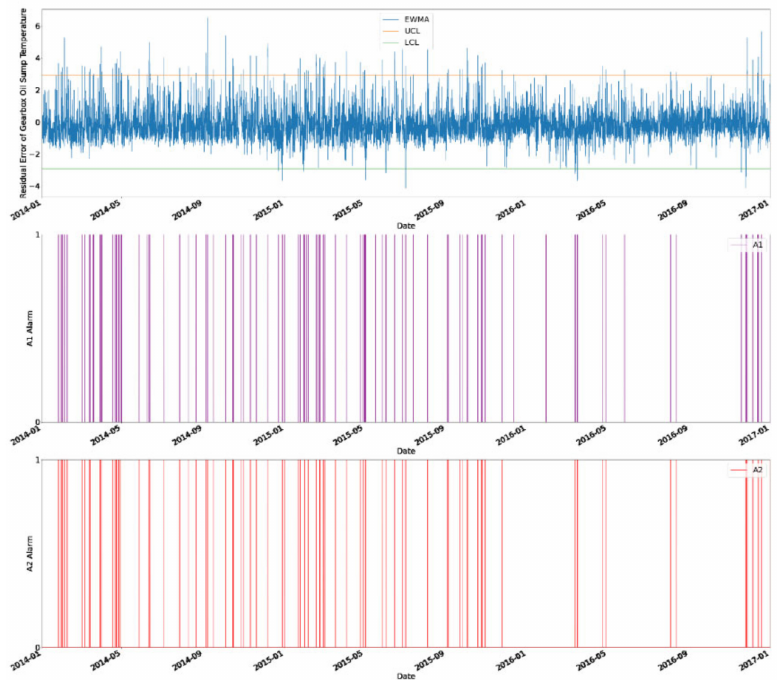
Figure 22. EWMA Chart with A1 and A2 Alarms.